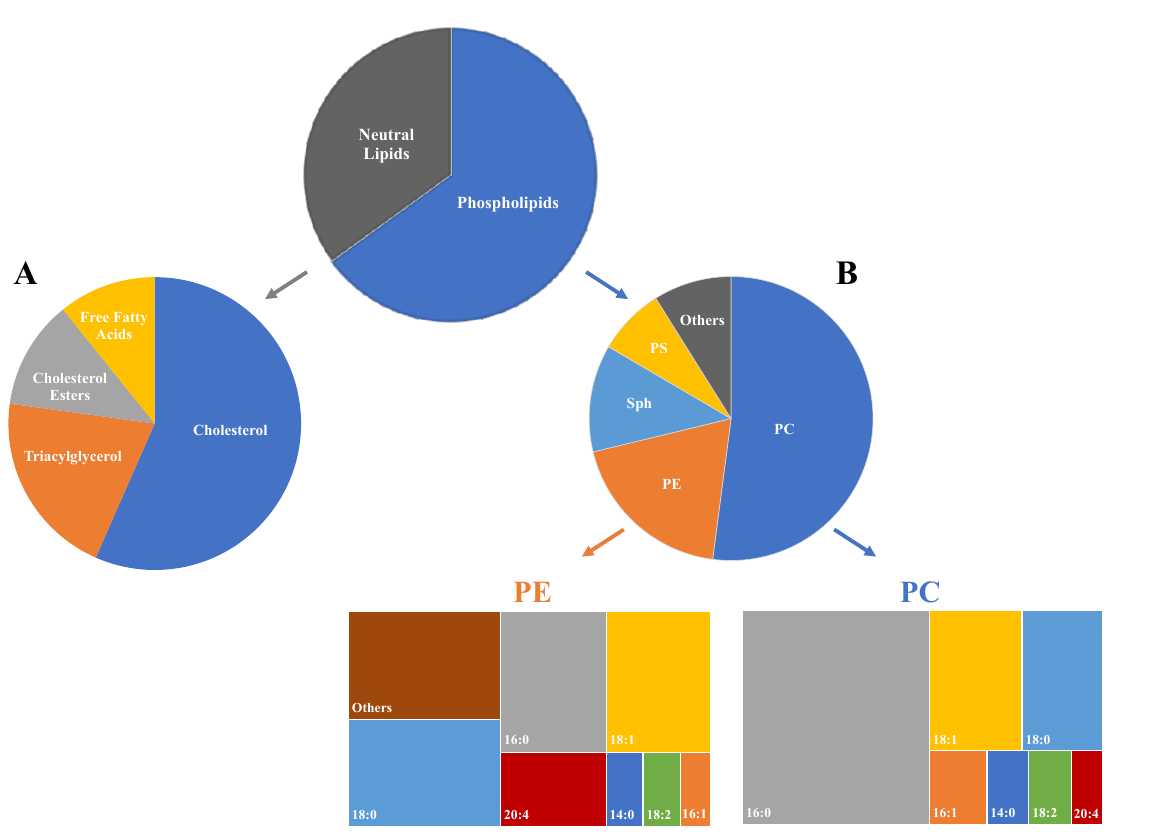
Figure 1. Lipid composition of lung tissue. ( A ) Neutral lipid breakdown; ( B ) phospholipid break- down and relative fatty acid compositions (treemap charts) for the major phosphatides phosphati- dylethanolamine (PE) and phosphatidylcholine (PC). For a key to abbreviations, see list at end of article.